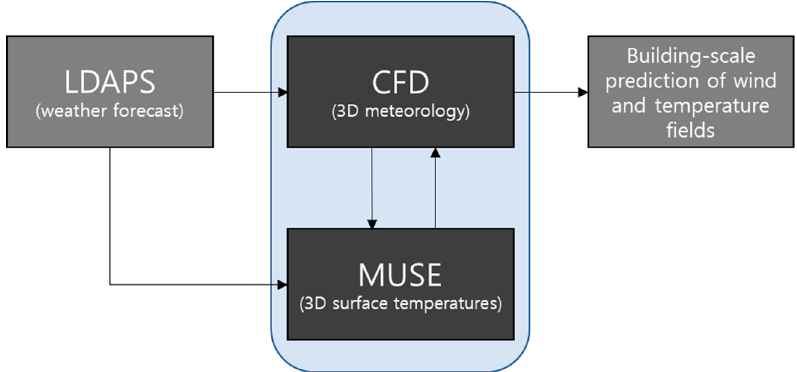
Figure 1. Schematic diagram of the building-scale meteorological prediction system.